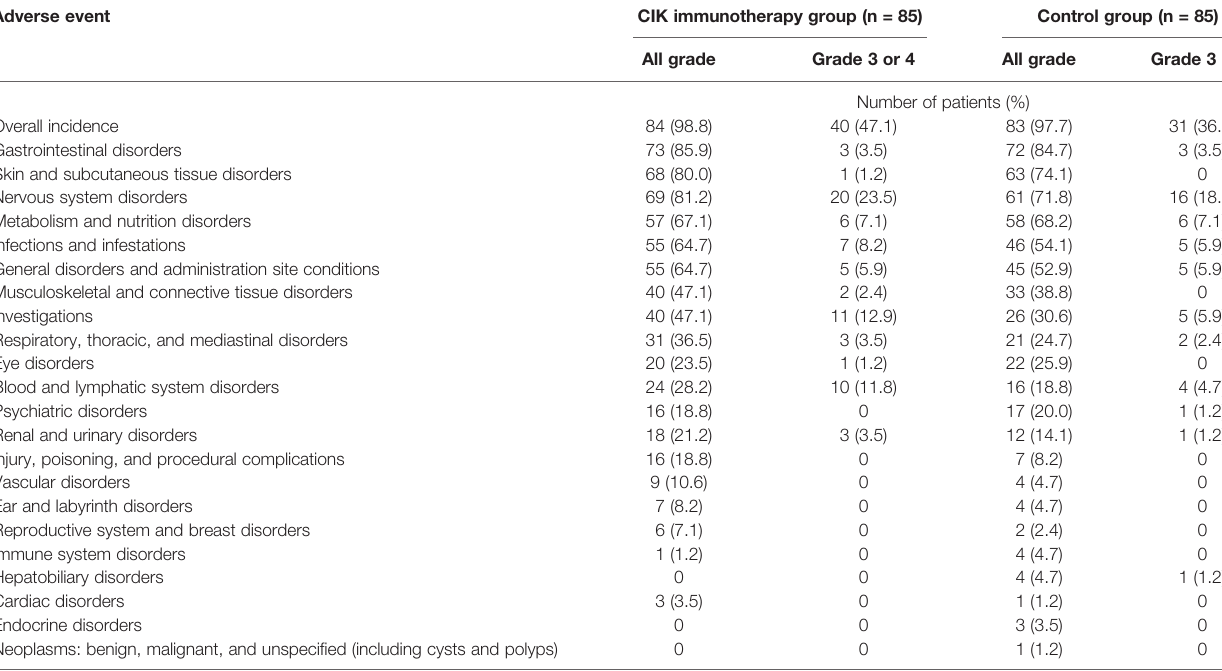
TABLE 4 | Adverse events of patients in the safety population. Adverse event CIK immunotherapy group (n =